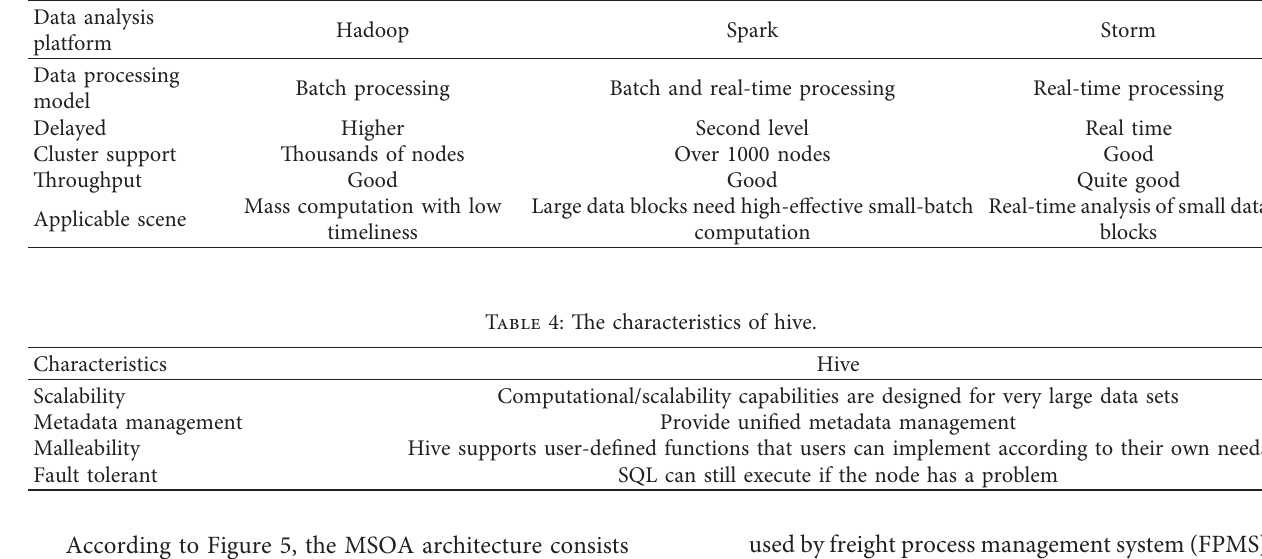
Table 3: Performance comparison between spark and other data analysis platforms.